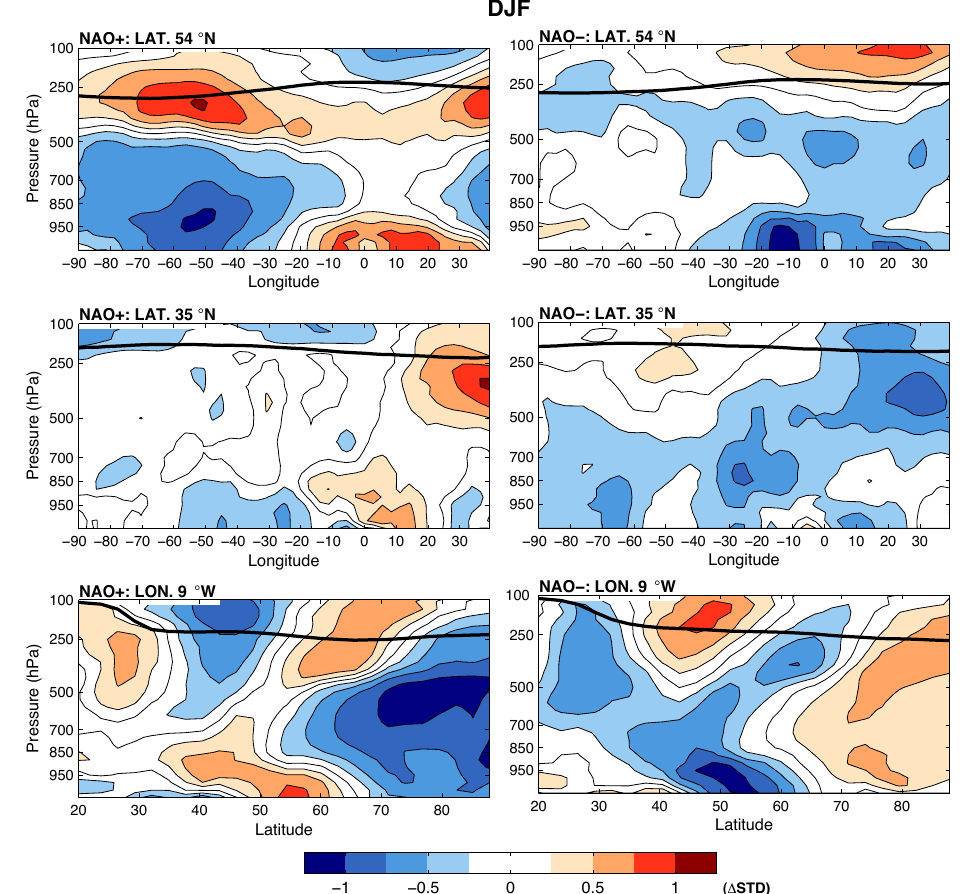
Fig. 7. Transect of normalized O 3 mixing ratio anomalies for a given latitude (upper and middle panels) and longitude (lower panels) as a function of pressure in winter (DJF). O 3 mixing ratio anomalies are normalized by O 3 standard deviation. Thick solid line indicates the tropopause